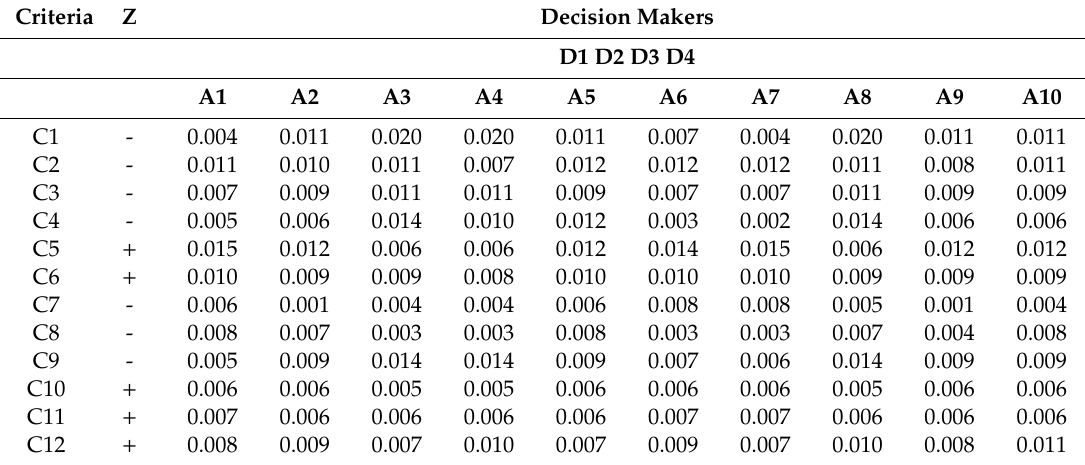
Table 8. Defuzzified, normalized and weighted decision matrix.